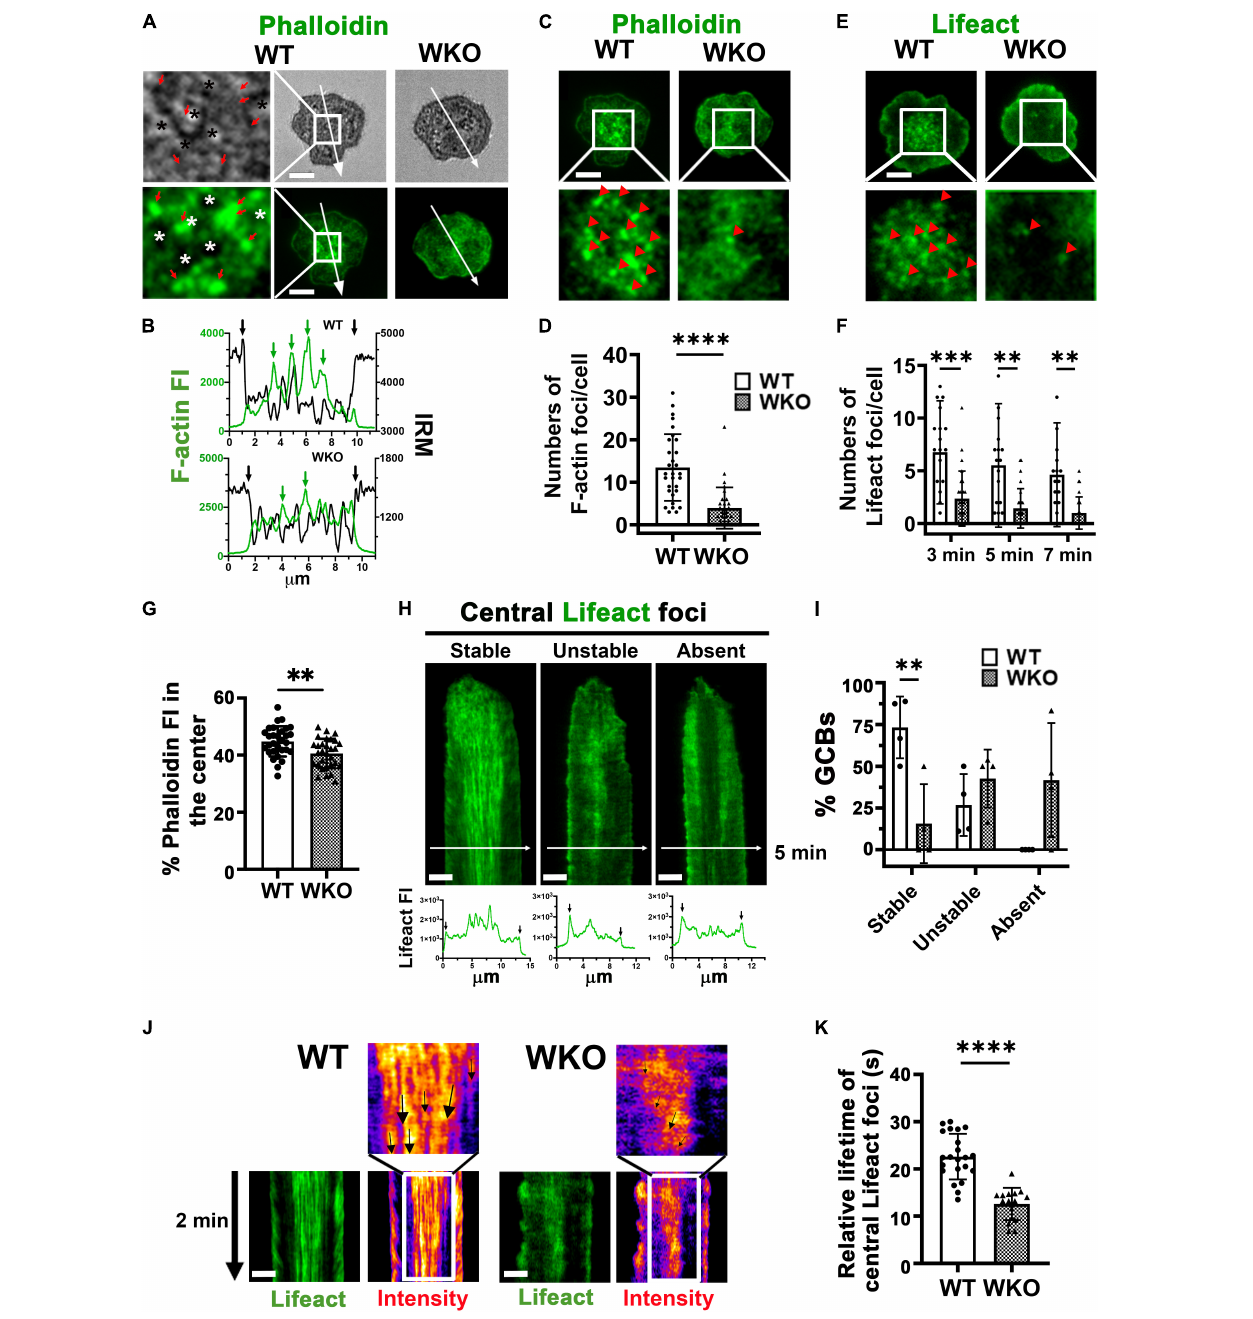
FIGURE 5 | WASp is required for generating stable F-actin foci at the centralized membrane protrusions in the GCB contact zone. GCBs isolated from SRBC-immunized WT and WKO mice expressing or not Lifeact-GFP were incubated with Fab’-PLB and either fixed, permeabilized, stained with phalloidin and imaged, or imaged live using IRM and TIRF. (A) Representative IRM and TIRF images of phalloidin staining of WT and WKO GCBs at 7 min and enlarged images of the central area in the WT GCB contact zone (left panels). Star *, the plasma membrane areas pulled away from Fab’-PLB. Red arrows, the plasma membrane areas were in close contact with Fab’-PLB. (B) The FI of phalloidin staining and the density of IRM image along the arrowed lines of WT (top) and WKO (bottom) cells in (A) . (C) Representative images of fixed GCBs stained with phalloidin and their central area of the contact zone at 7 min. Red arrowheads, phalloidin stained F-actin foci identified by the MFI of individual foci that were 2 folds higher than the MFI of the entire contact zone. (D) The number of phalloidin-stained F-actin foci per GCB contact zone at 7 min. Data points represent individual cells. (E) Representative images of Lifeact-GFP expressing GCBs and their enlarged central area of the contact zone at 7 min. Red arrowheads, Lifeact-GFP F-actin foci identified by the MFI of individual foci that were 1.5 fold higher than the MFI of the entire contact zone. (F) The number of Lifeact-GFP foci per GCB contact zone at 3, 5, and 7 min. Data points represent individual cells. (G) Percentages of the phalloidin FI in